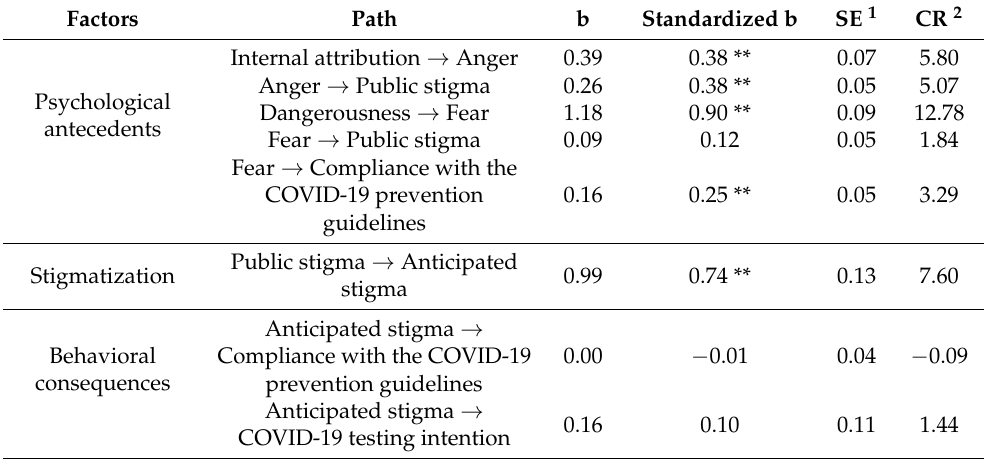
Figure 3. The standardized path coefficients for the conceptual model among participants in their 60s. ** p < 0.01. Table 4. The causal relationships between measures for participants in their